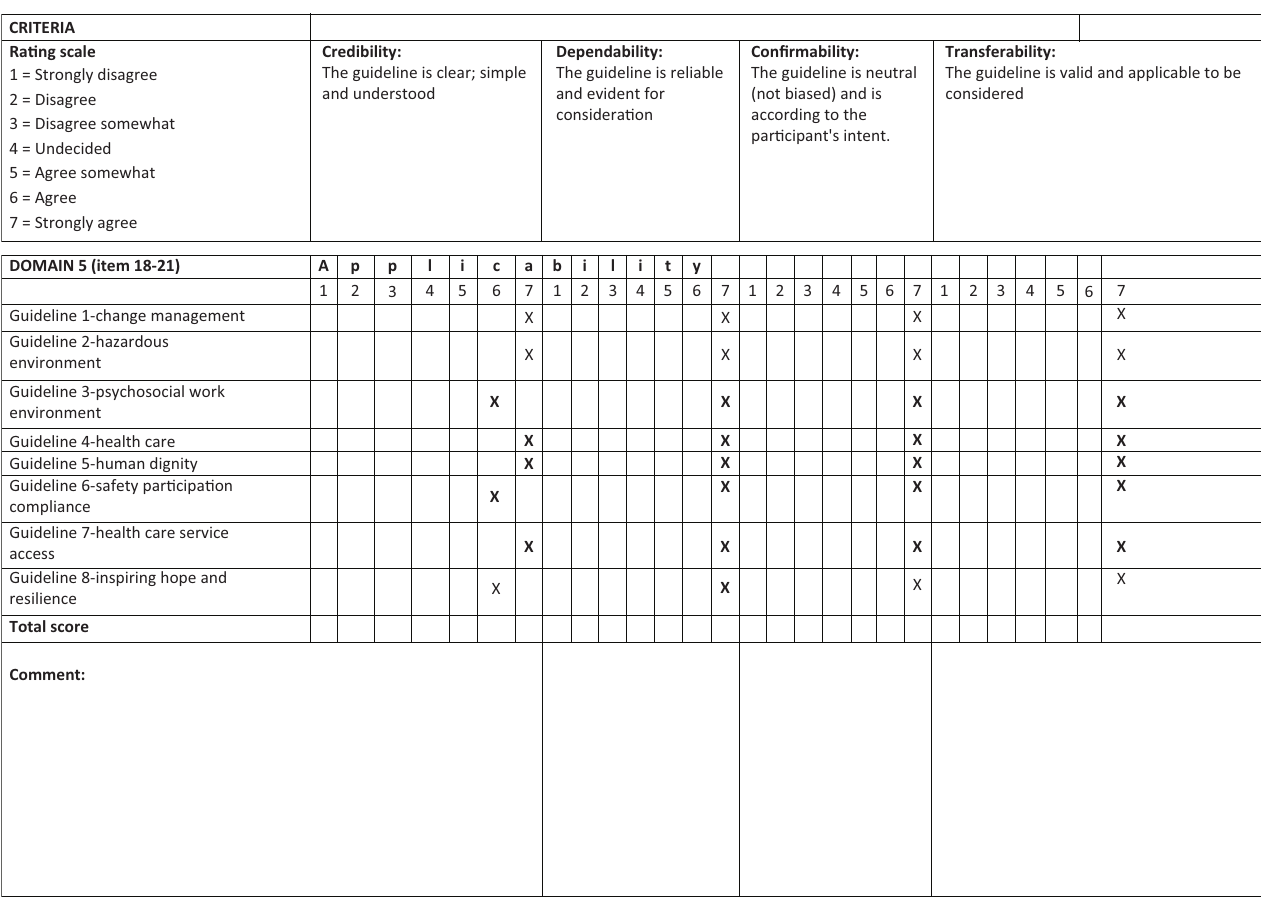
FIGURE 2: An example of the rated scale from the